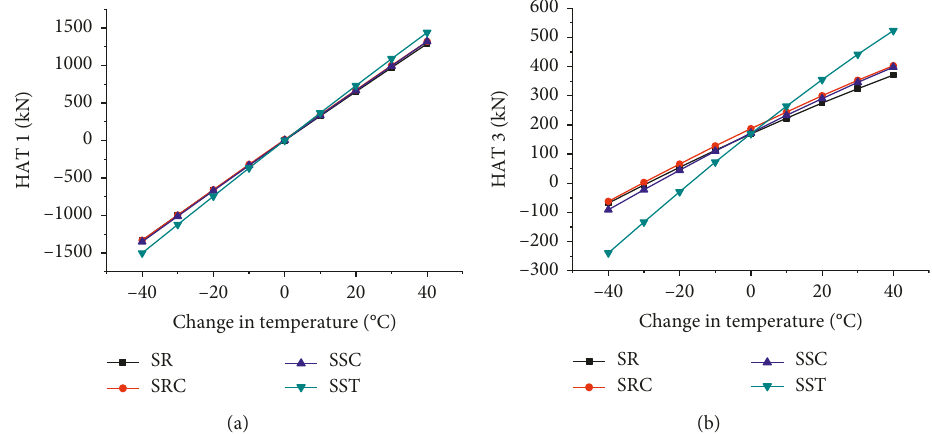
Figure 13: Relationship between the horizontal arch thrust and the temperature in the half-span load distribution. Change in (a) HAT1 and (b) HAT 3 with varying temperature.